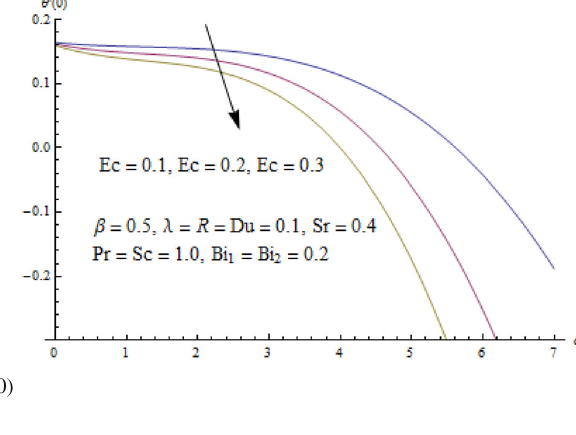
Fig. 28 Impact of Ec on θ (cid:5) ( 0 )